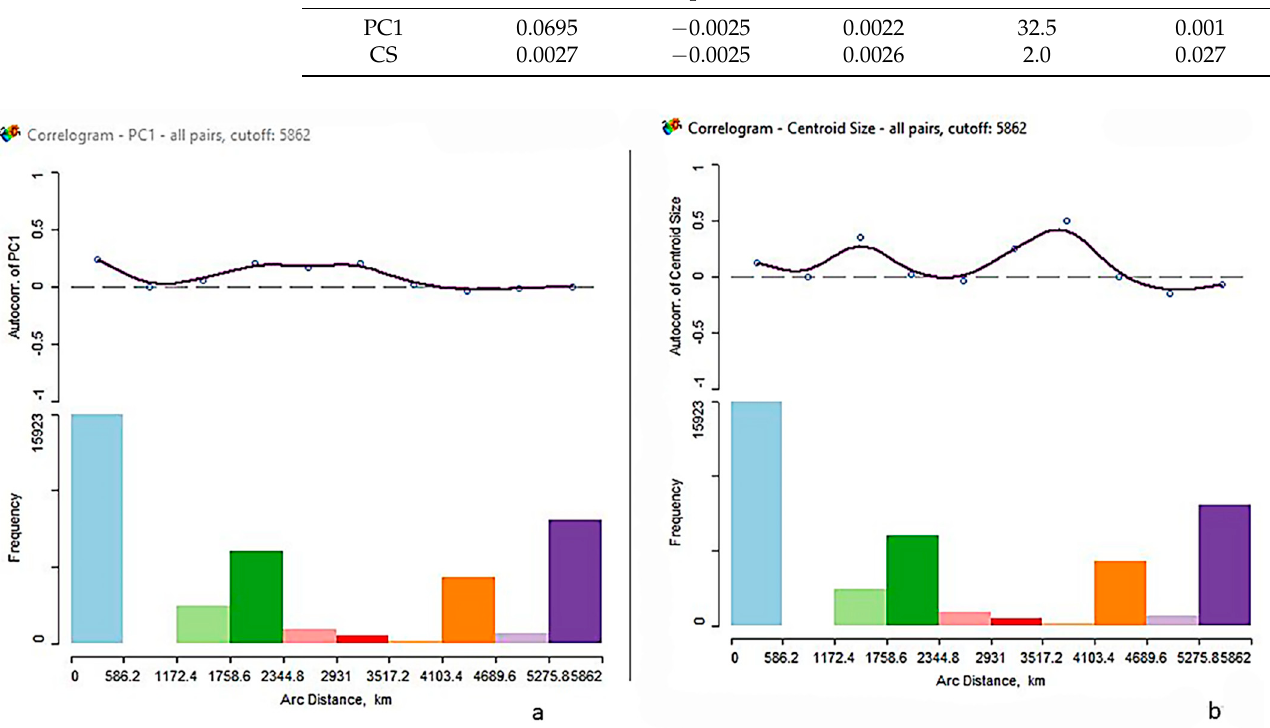
Figure 5. Correlograms for shape ( a ) and size ( b ) depicting the spatial autocorrelation. Moran’s I by distance in kilometers.